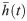
Realization-dependent symmetry breaking in the self-tuned chaotic regime.(A) Sample traces of coherent mode current, h¯(t), (top) and histogram of values of h¯(t) (bottom) from a connectivity realization with real eigenvalue for J1 = 40,60,80 increasing from left to right. Dynamics exhibit pronounced asymmetry. (B) Absolute value of the time-average coherent mode current, ∣〈h¯〉∣, as a function of J1. Each colored line represents a single connectivity realization, averaged over 10 initial conditions. For many individual realizations, ∣〈h¯〉∣ is significantly non-zero over a large range of values of J1, while still not arriving at fixed point value (displayed by dashed line). We display the 37 realizations with real leading eigenvalue out of 100 total realizations from this set of trials. Thick black line shows average over those realizations. Dashed line shows h¯c=ϕ′-1(1g). N = 8000 for all panels.